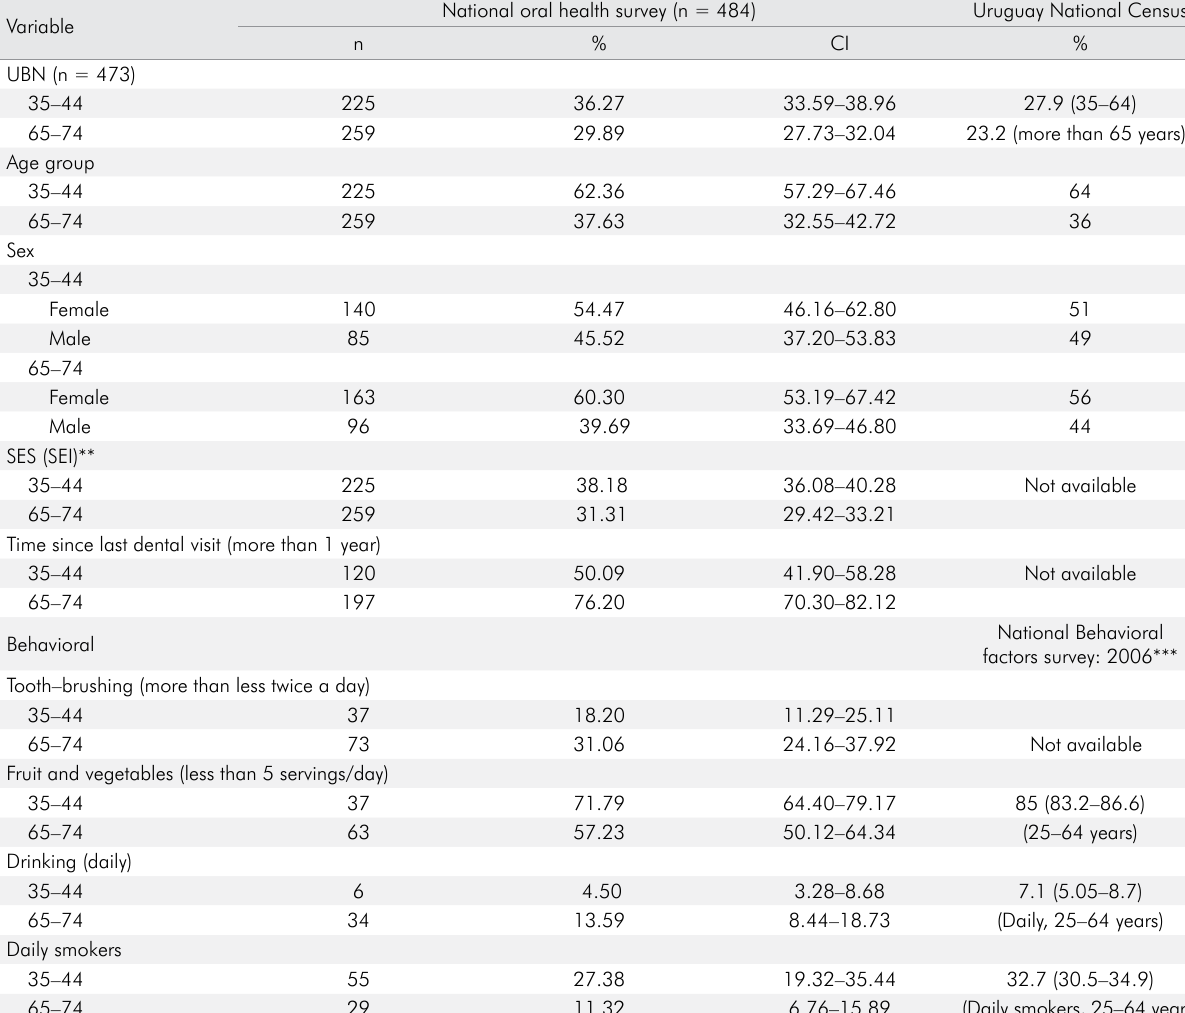
Table 3. Characteristics of the sample and the population of 35–44 and 65–74.